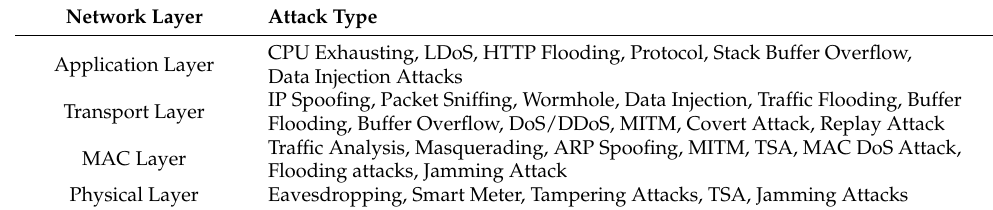
Table 3. Smart grid cyberattacks according to network layers